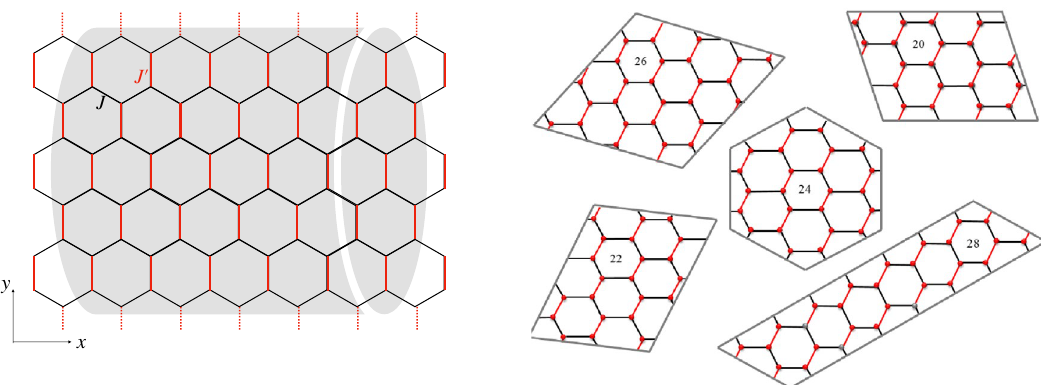
Figure 1. Schematic picture of the honeycomb lattice with different antiferromagnetic interaction coupling J and J ′ , as shown in black and red lines, respectively. The left panel shows a cylindrical cluster considered only within the numerical DMRG method, with the periodic boundary in the y -direction. The right panel shows finite-size flak clusters considered within the numerical Lanczos method, which the twist-periodic boundary is